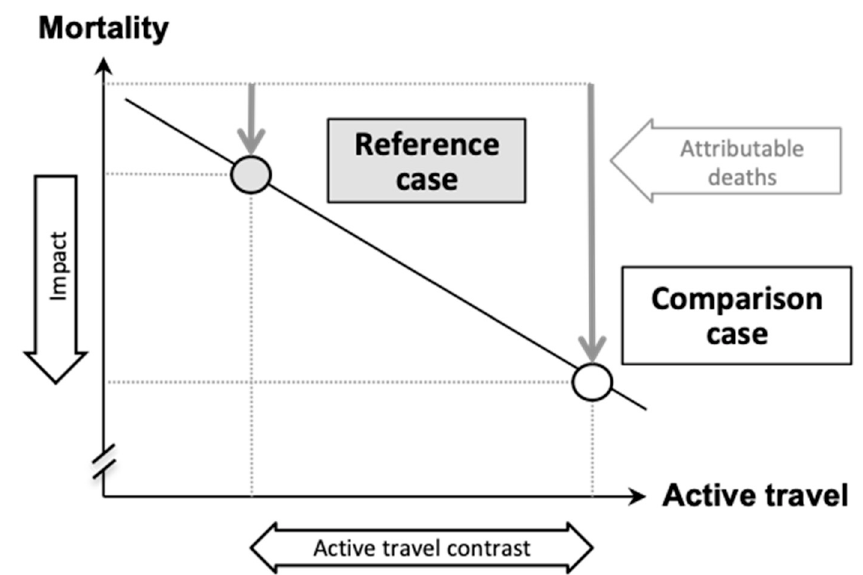
Figure 2. Schematic illustration of comparative risk assessment approach. Illustration depicts an example where increase in active travel from reference case to comparison case reduces mortality, i.e., is beneficial. Thus, attributable deaths in this case are “prevented deaths”. The top dotted line depicts the mortality level for a case without any active travel. In the reference case with lower active travel, fewer deaths are prevented, while in the comparison case with higher active travel more deaths are prevented due to active travel (Note: HEAT applies linear dose–response functions for physical activity, air pollution and crash risks).